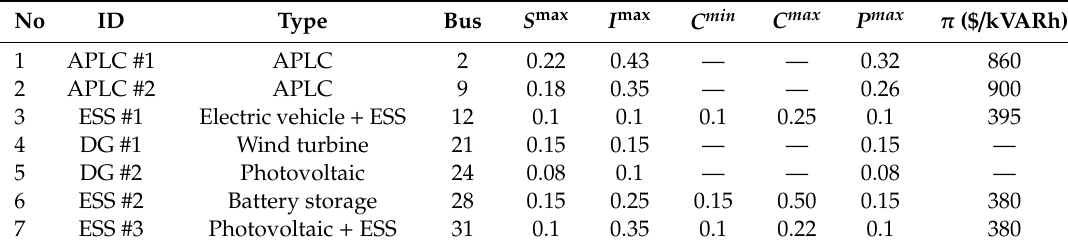
Table 3. Data of APLCs and DER of the network (values are in pu).